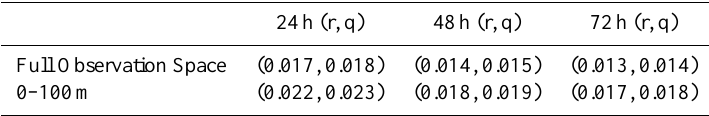
Table 2. Resolution for temperature.